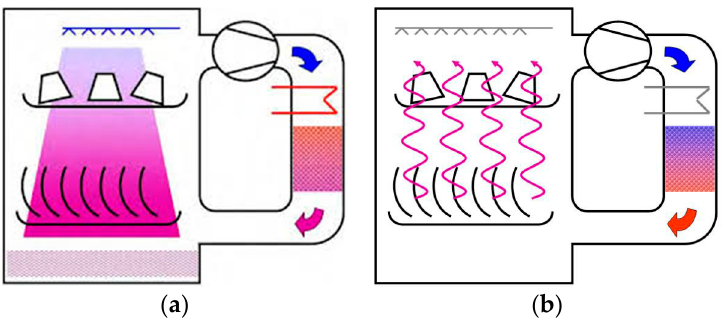
Figure 9. An adsorption based dishwasher. Washing phase ( a ); drying phase ( b ).